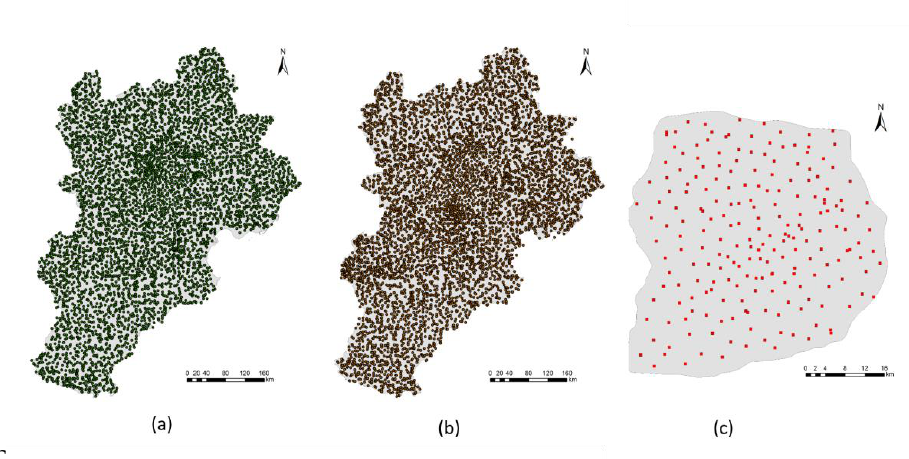
Figure 2. Location of samples selected in the BTH region, ( a ) vegetation samples; ( b ) bare soil samples; and ( c ) samples within the extent of the sixth ring of Beijing.